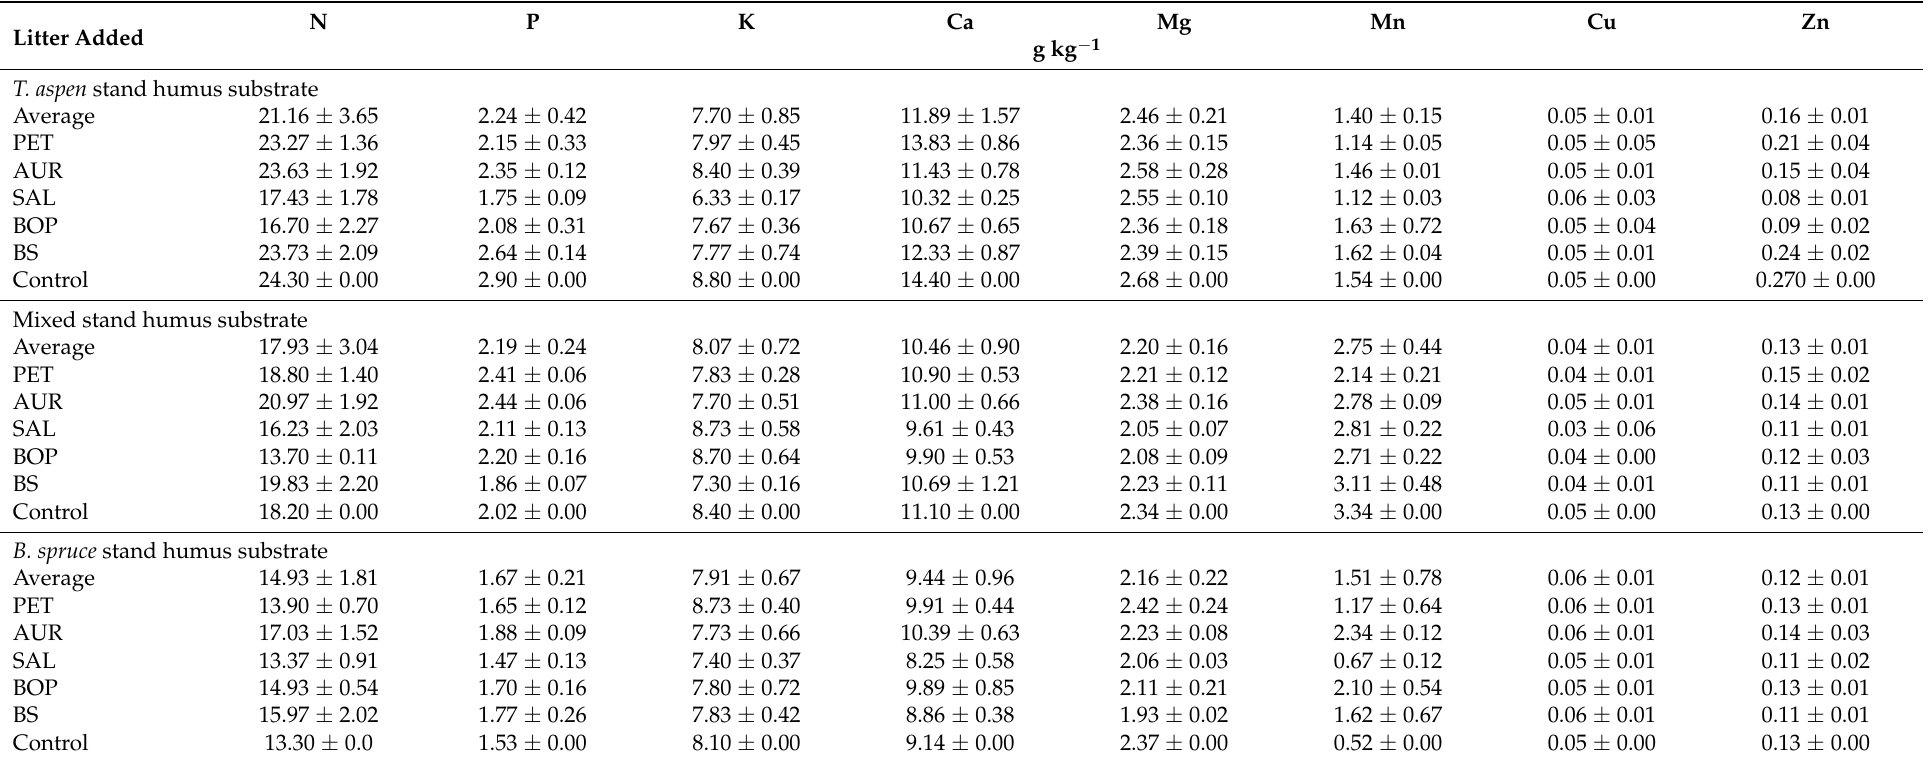
Table 5. Foliar concentrations of B. spruce seedlings grown in humus from different forest stands and topped with different litter types (mean ± SD from all litter amounts added). PET: T. aspen ; AUR: Alder sp.; SAL: Willow sp; BOP: White birch ; BS: B. spruce ; Control: no